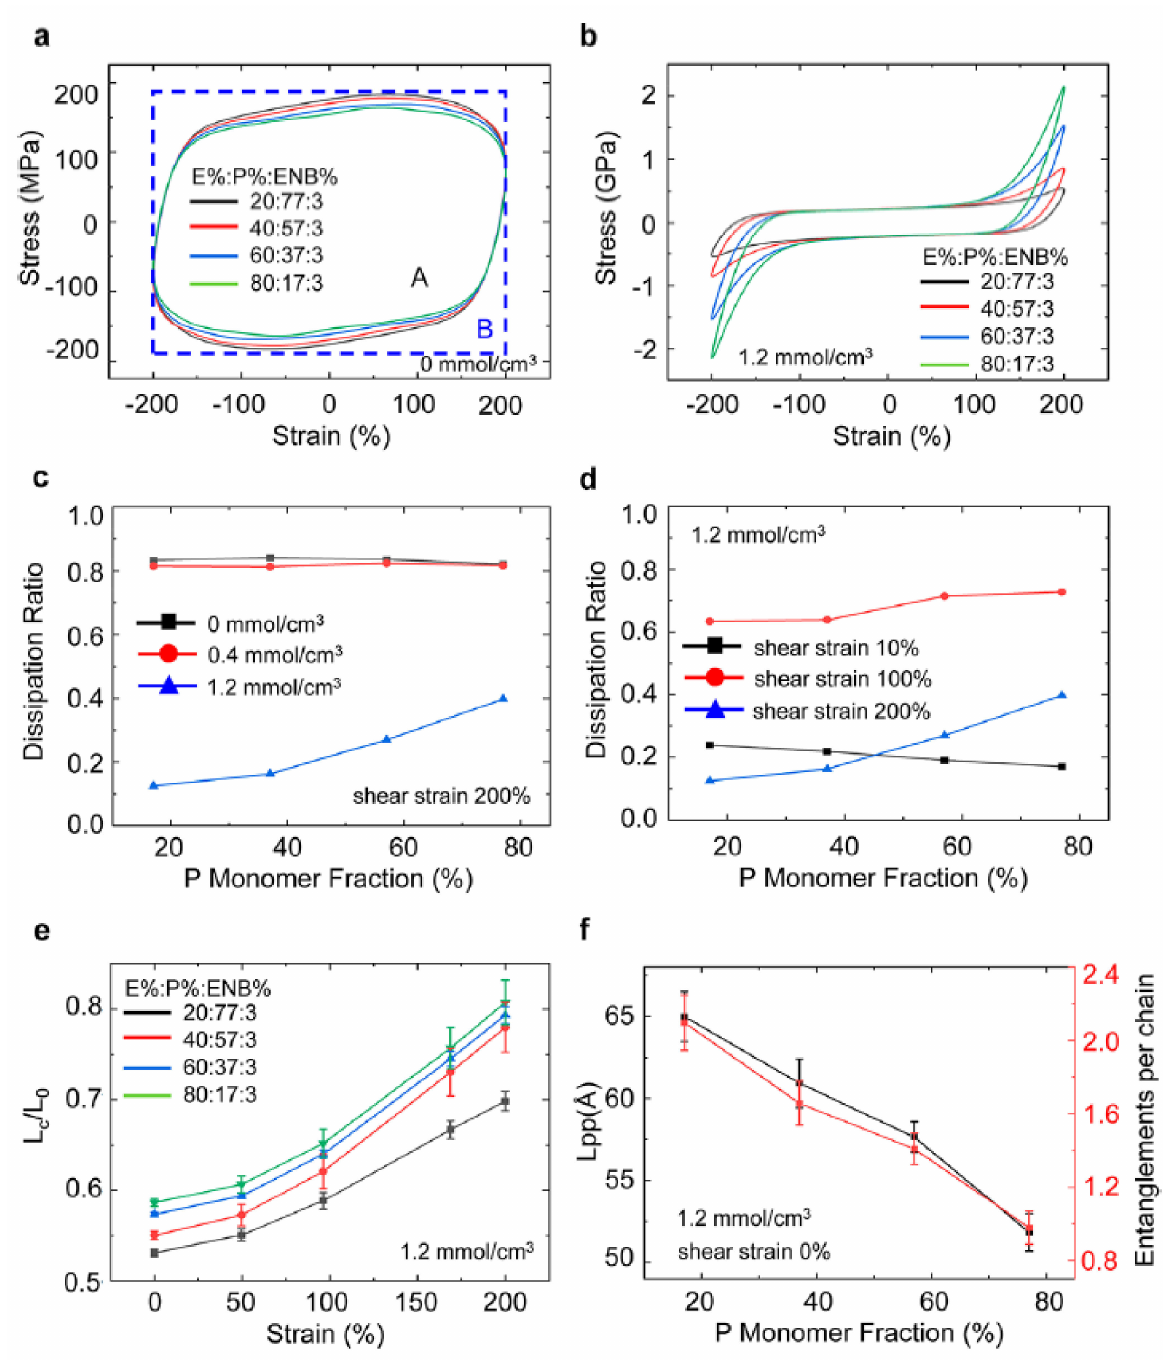
Figure 16. Influence of molecular design parameters on the EPDM dissipation ratio under large-strain deformation with a high frequency: ( a ) stress − strain curves of un-crosslinked EPDM with different ethylene (E), propylene (P), and ENB fractions; ( b ) stress − strain curves of crosslinked EPDM with different monomer fractions; ( c ) dissipation ratio of EPDM under different propylene fractions with varying crosslink densities at the shear strain of 200%; ( d ) dissipation ratio of highly crosslinked EPDM under different propylene fractions with varying shear strain amplitudes; ( e ) normalized mean distance between crosslinks of highly crosslinked EPDM under different propylene fractions with varying shear strain amplitudes; ( f ) primitive path length and entanglements per chain of highly crosslinked EPDM at the shear strain of 0%